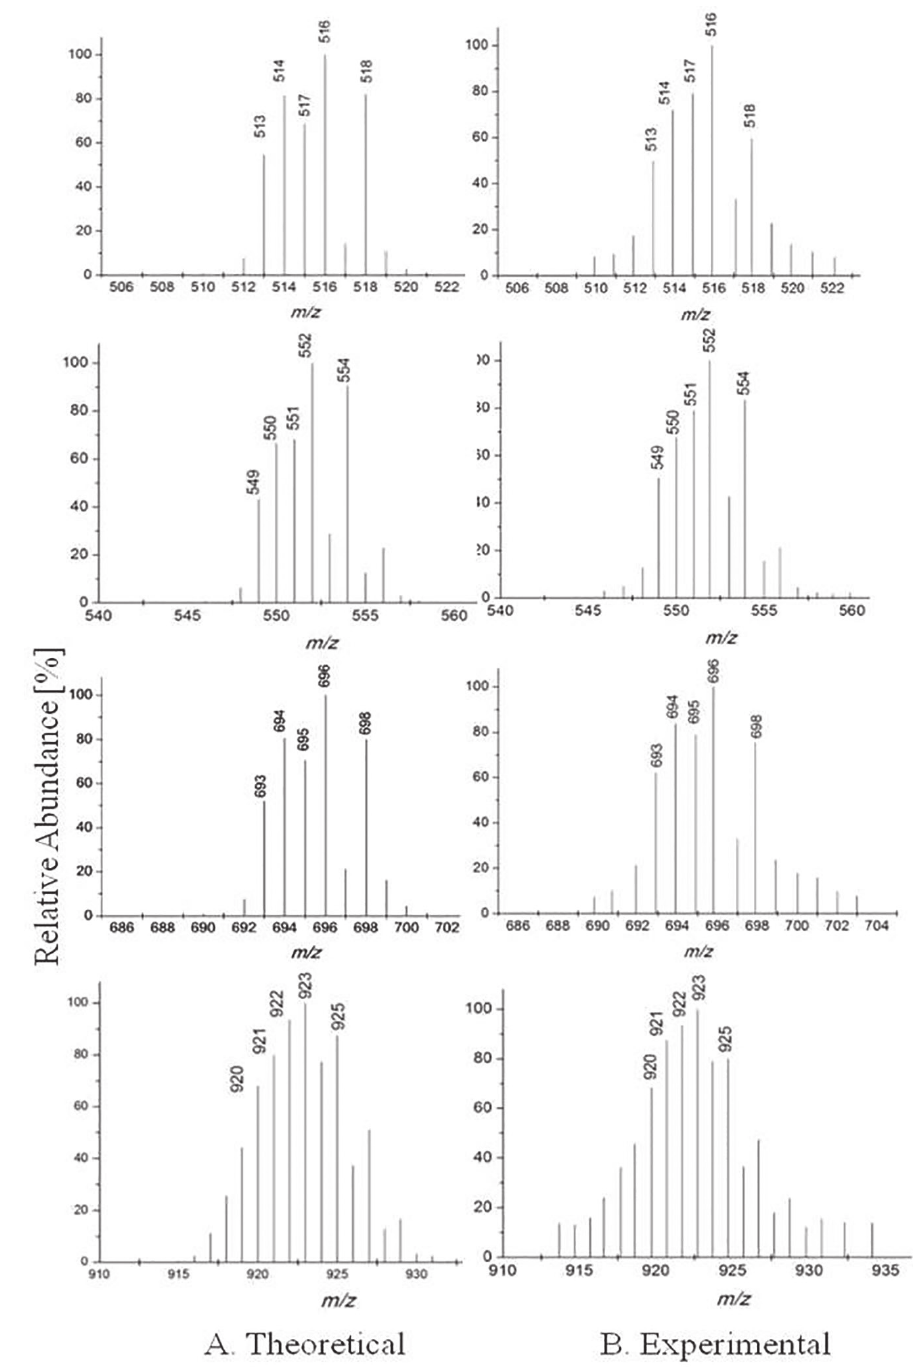
FIGURE 3 - (A) theoretical mass spectra and (B) experimental mass spectra of the Gd-Glu solution in the regions of m/z : 516 to C H O Gd; 552 to C 12 22 12